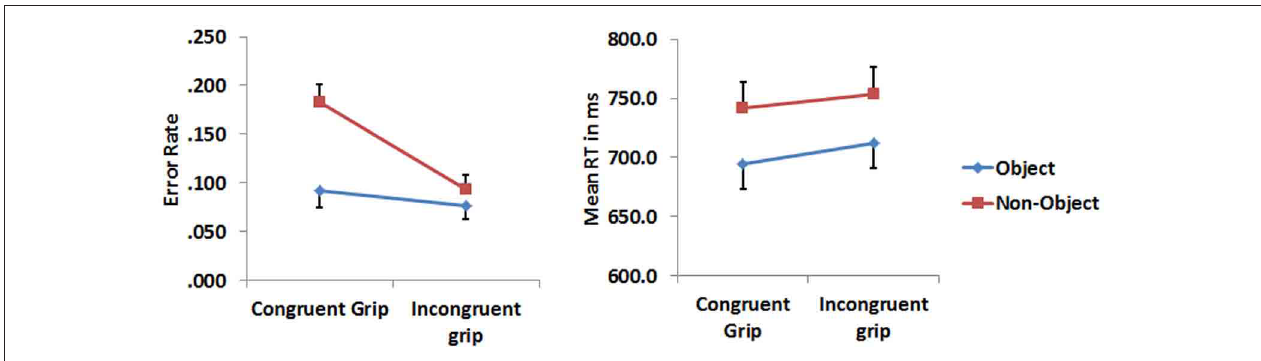
FIGURE 3 | The error rate and RTs related to congruently and incongruently gripped objects and non-objects. The error bars represent 1 standard